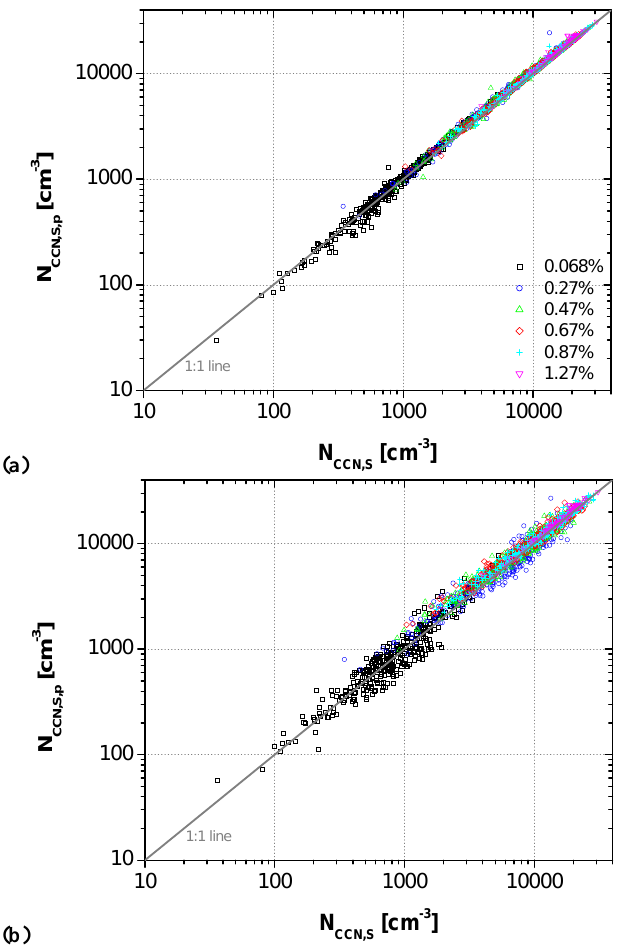
Fig. 10. Predicted CCN number concentrations ( N CCN , S , p ) based on the κ -K¨ohler model approach (a) with variable values of κ t as derived from individual CCN efficiency spectra and (b) with a con- stant average value of κ =0.3 plotted against the observed CCN num- ber concentrations ( N CCN , S